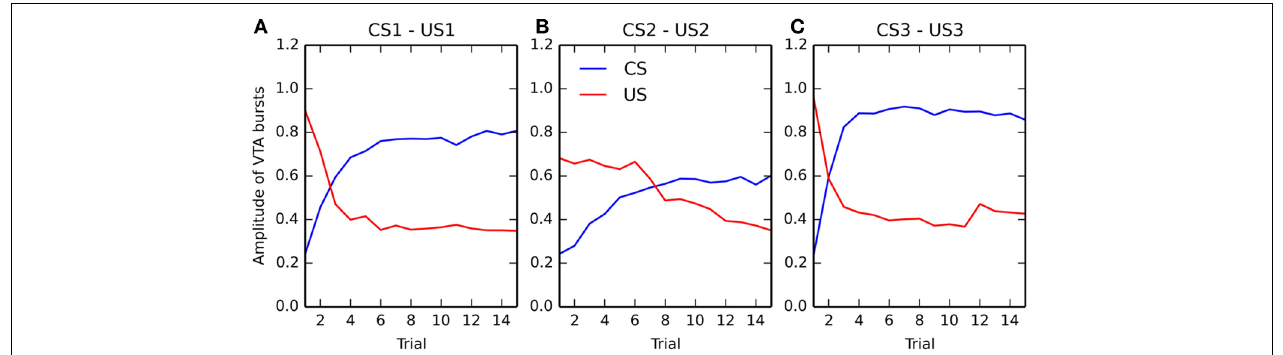
FIGURE 6 | Evolution of the maximal activity in VTA during conditioning. For each of the three associations (panels (A–C) , respectively), the maximal activity of the VTA cell at CS onset (in blue) and at reward delivery (in red) is plotted for each trial of the conditioning phase. These values are computed by